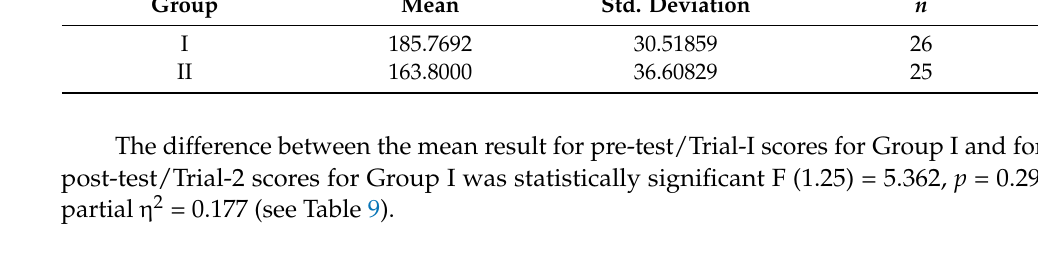
Table 8. Mean results for emotional intelligence quotient for the ANCOVA model for Group I and II. Group Mean